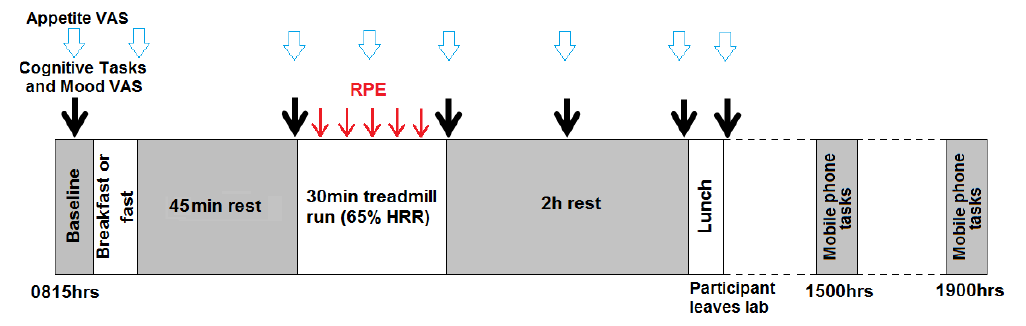
Figure 1. Main study schematic.